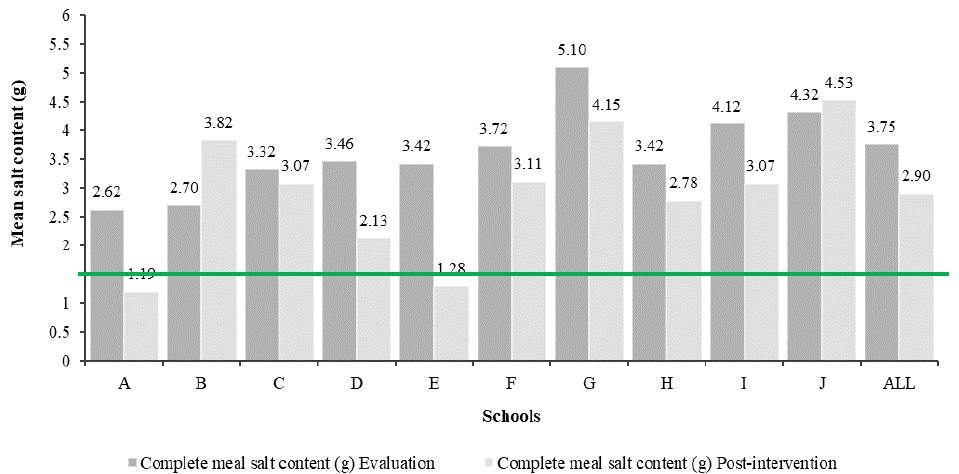
Figure 1. Mean salt content (g) of the complete school meals analyzed at the evaluation phase and the post-intervention phase of the eat Mediterranean program and its adequacy regarding the reference value (maximum 1.5 g of salt/meal), by the school.